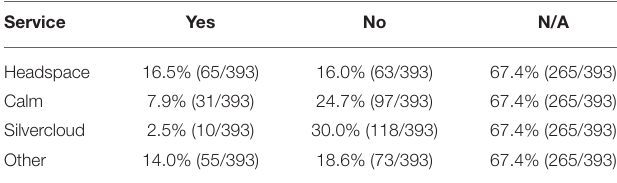
TABLE 3 | Use of mental health mobile applications.